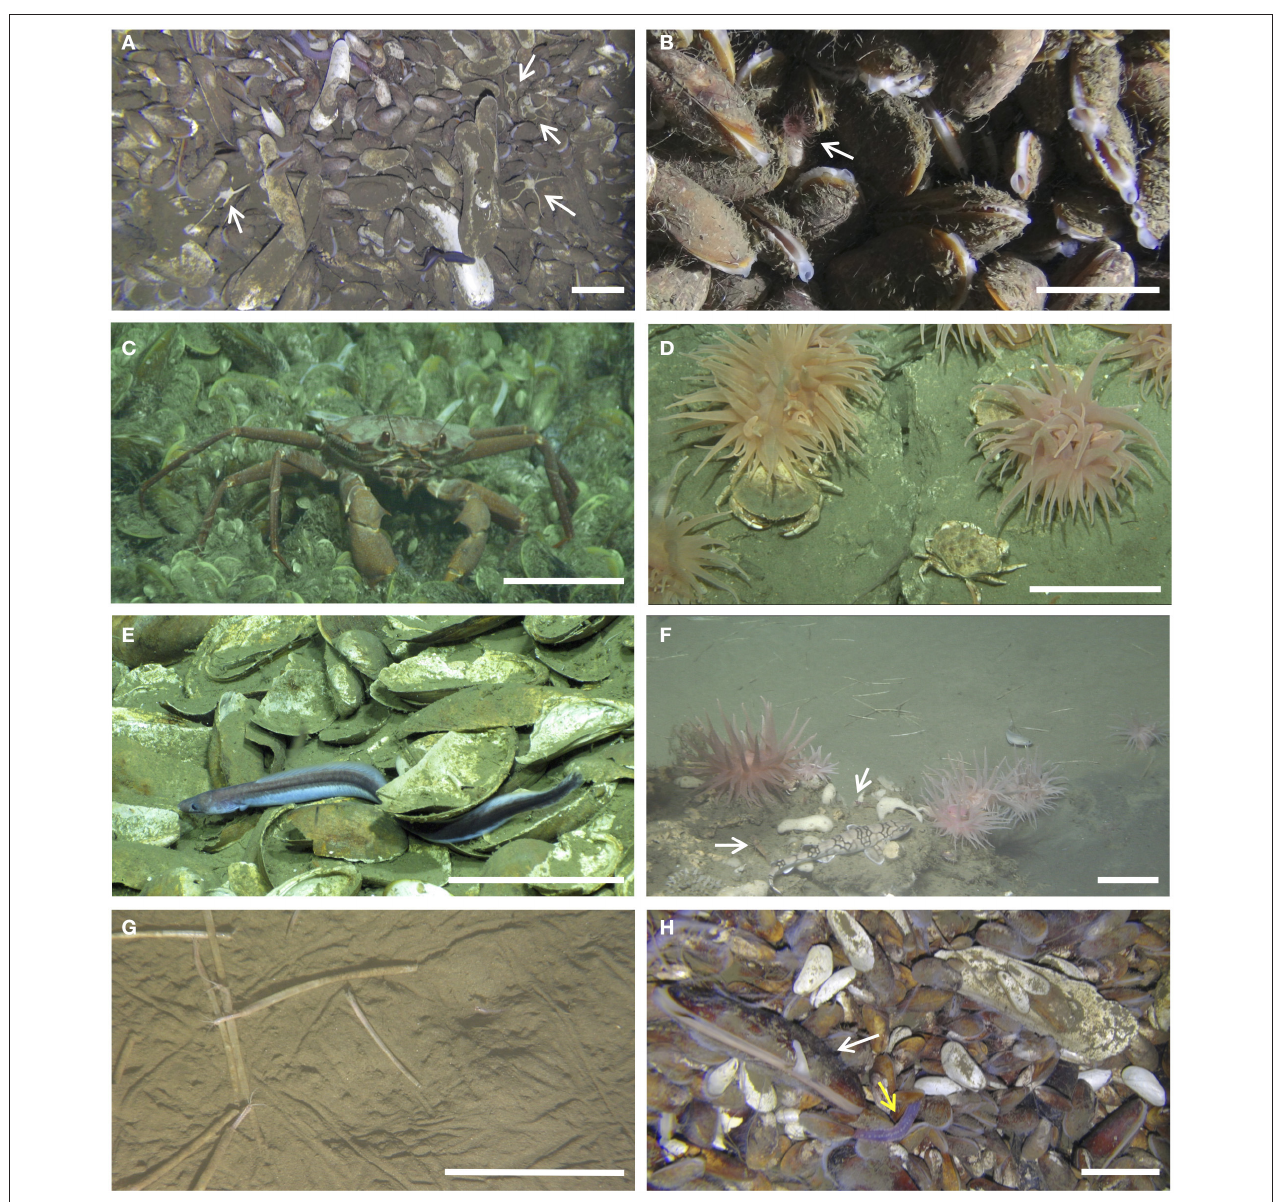
FIGURE 2 | Fauna important in distinguishing seep communities. (A) Ophiuroids (arrows) at Norfolk West, along with dead mussel shells cf. Bathymodiolus heckerae (Dive 4803). (B) Small, red anemone Actiniaria sp. 4 (arrow) at Norfolk East (Dive 4802). (C) Red crab ( Chaceon quinquedens ) at Norfolk East (Dive 4802). (D) Jonah crab ( Cancer borealis ) and the anemone Urticina sp. at Shallop West (Dive 4812). (E) A cutthroat eel ( Dysommina rugosa ) at Baltimore (image courtesy of S W Ross; Ross et al., 2015). (F) The anemone Urticina sp. at Pick-Up Sticks, along with sponges, a chain catshark ( Scyliorhinus retifer ), caridean shrimp (arrows) and, on the background sediment, onuphid quill worms ( Hyalinoecia artifex ) and a short-beard codling ( Laemonema barbatulum ; Dive 4805). (G) H. artifex at Pick-Up Sticks (Dive 4805). (H) A live mussel cf. B. heckerae (white arrow) and the purple holothurian Chiridota heheva (yellow arrow) at Norfolk West (Dive 4803). Scale bars: ∼